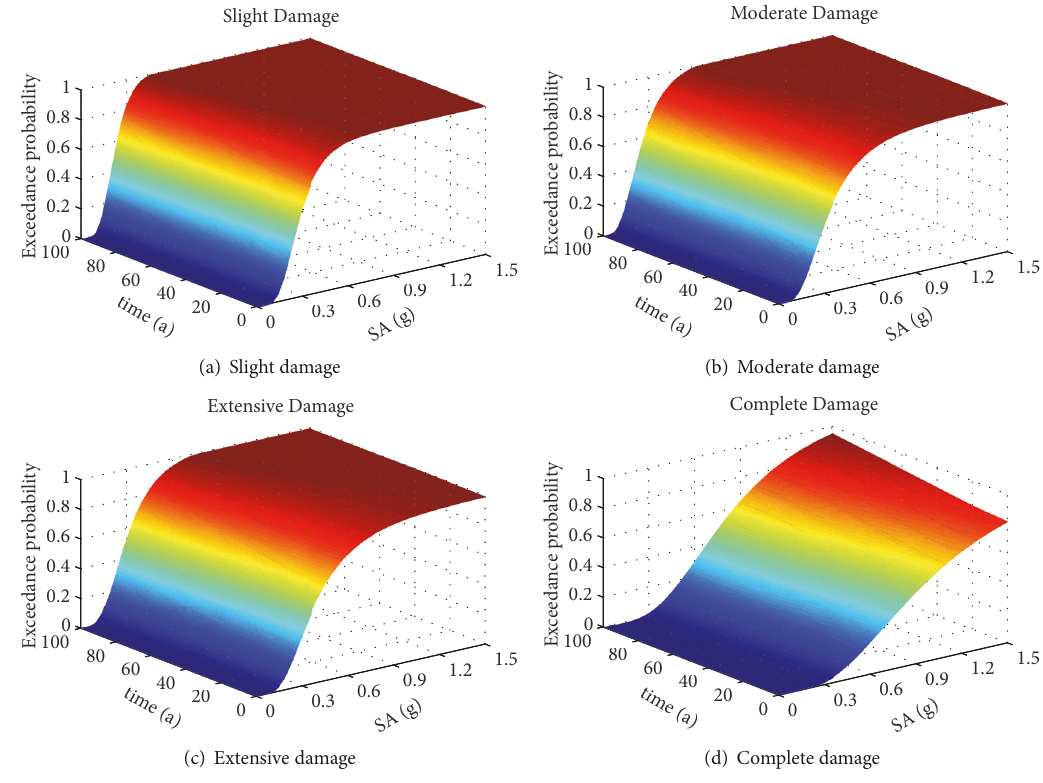
Figure 11: The vulnerability surfaces of 1 # pier under different damage